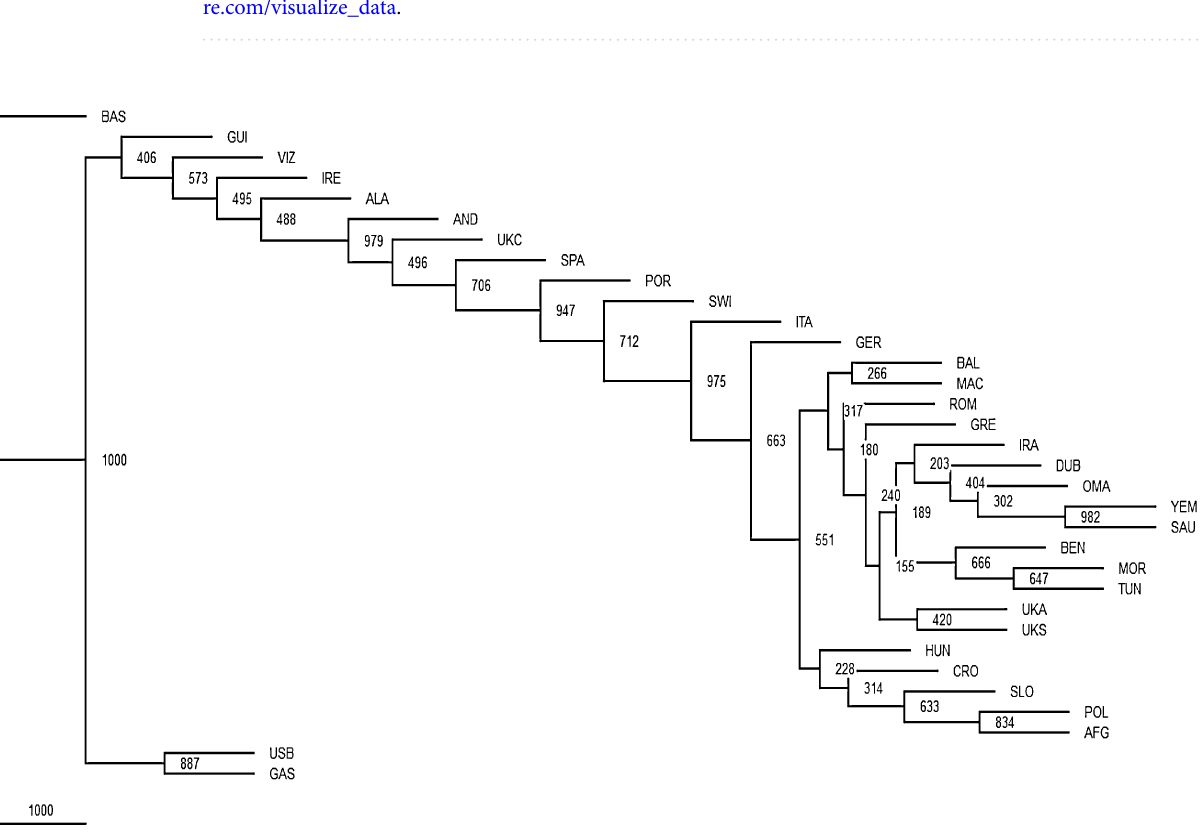
Figure 3. NJ tree. PHYLIP 3.52c at https ://www.resea rchga